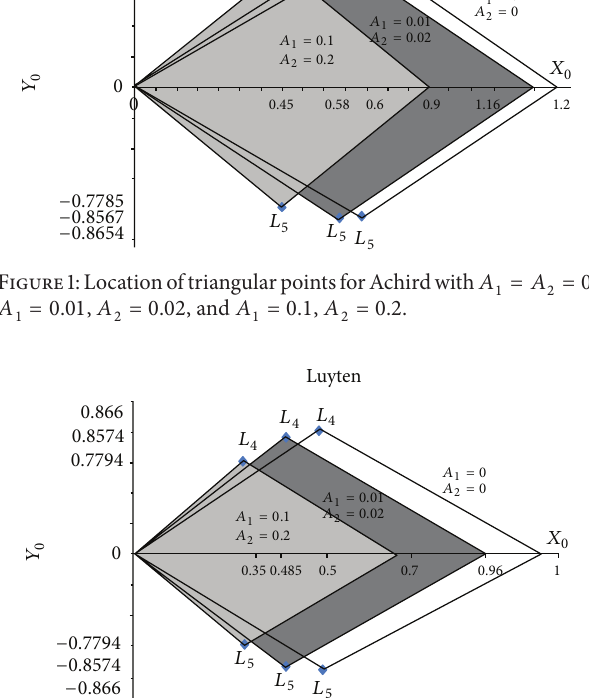
Figure 2: Location of triangular points for Luyten with 𝐴 1 = 𝐴 2 = = 0.01 , 𝐴 = 0.02 , and 𝐴 0 , 𝐴 1 2